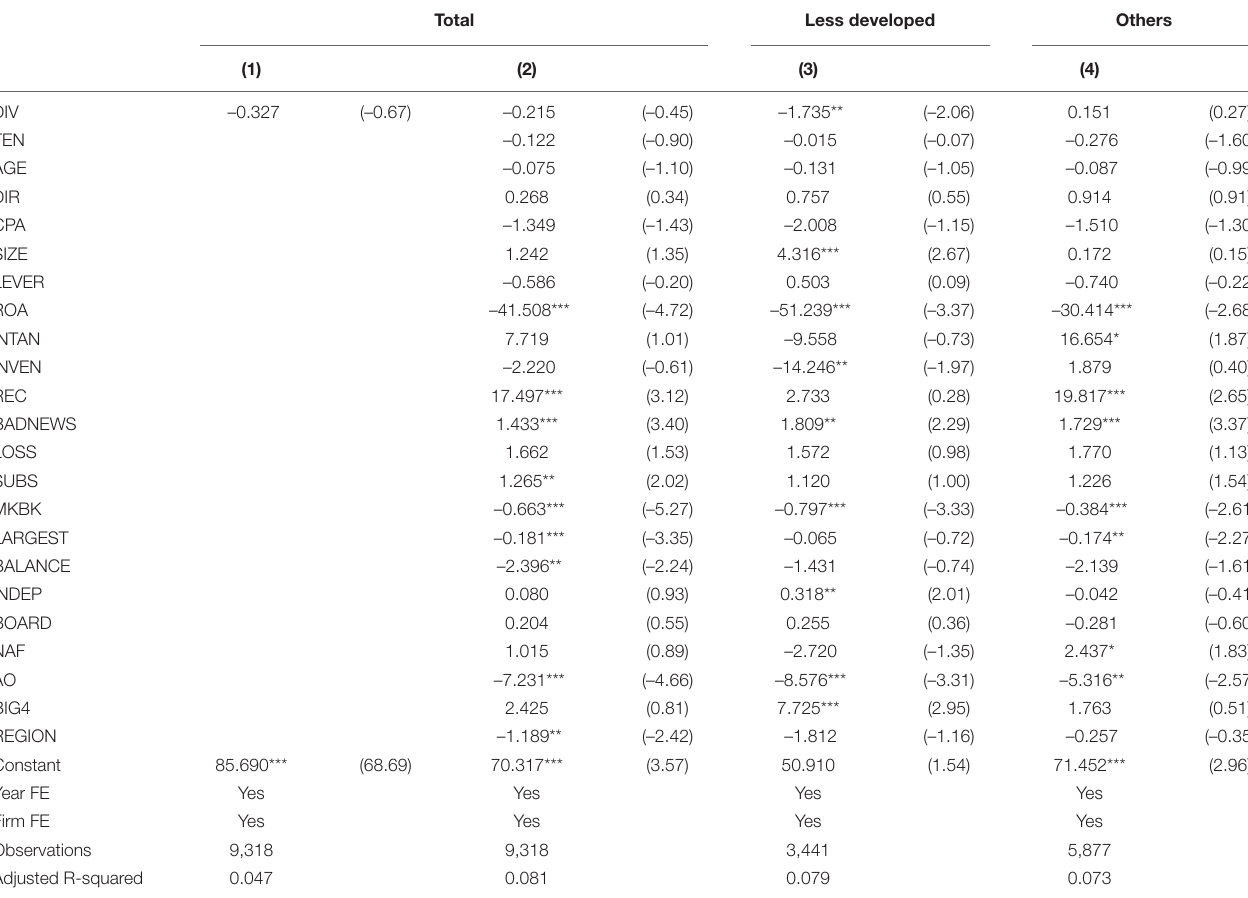
TABLE 6 | CFO functional diversity and timeliness for PEs